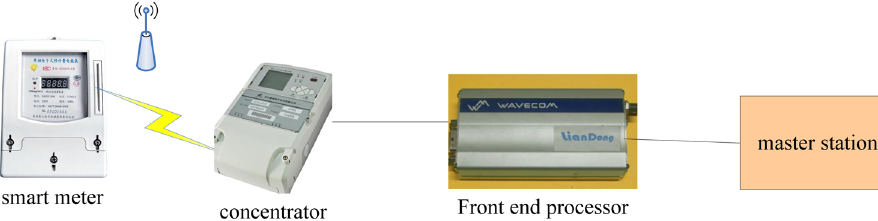
Figure 1: Smart meter network topology